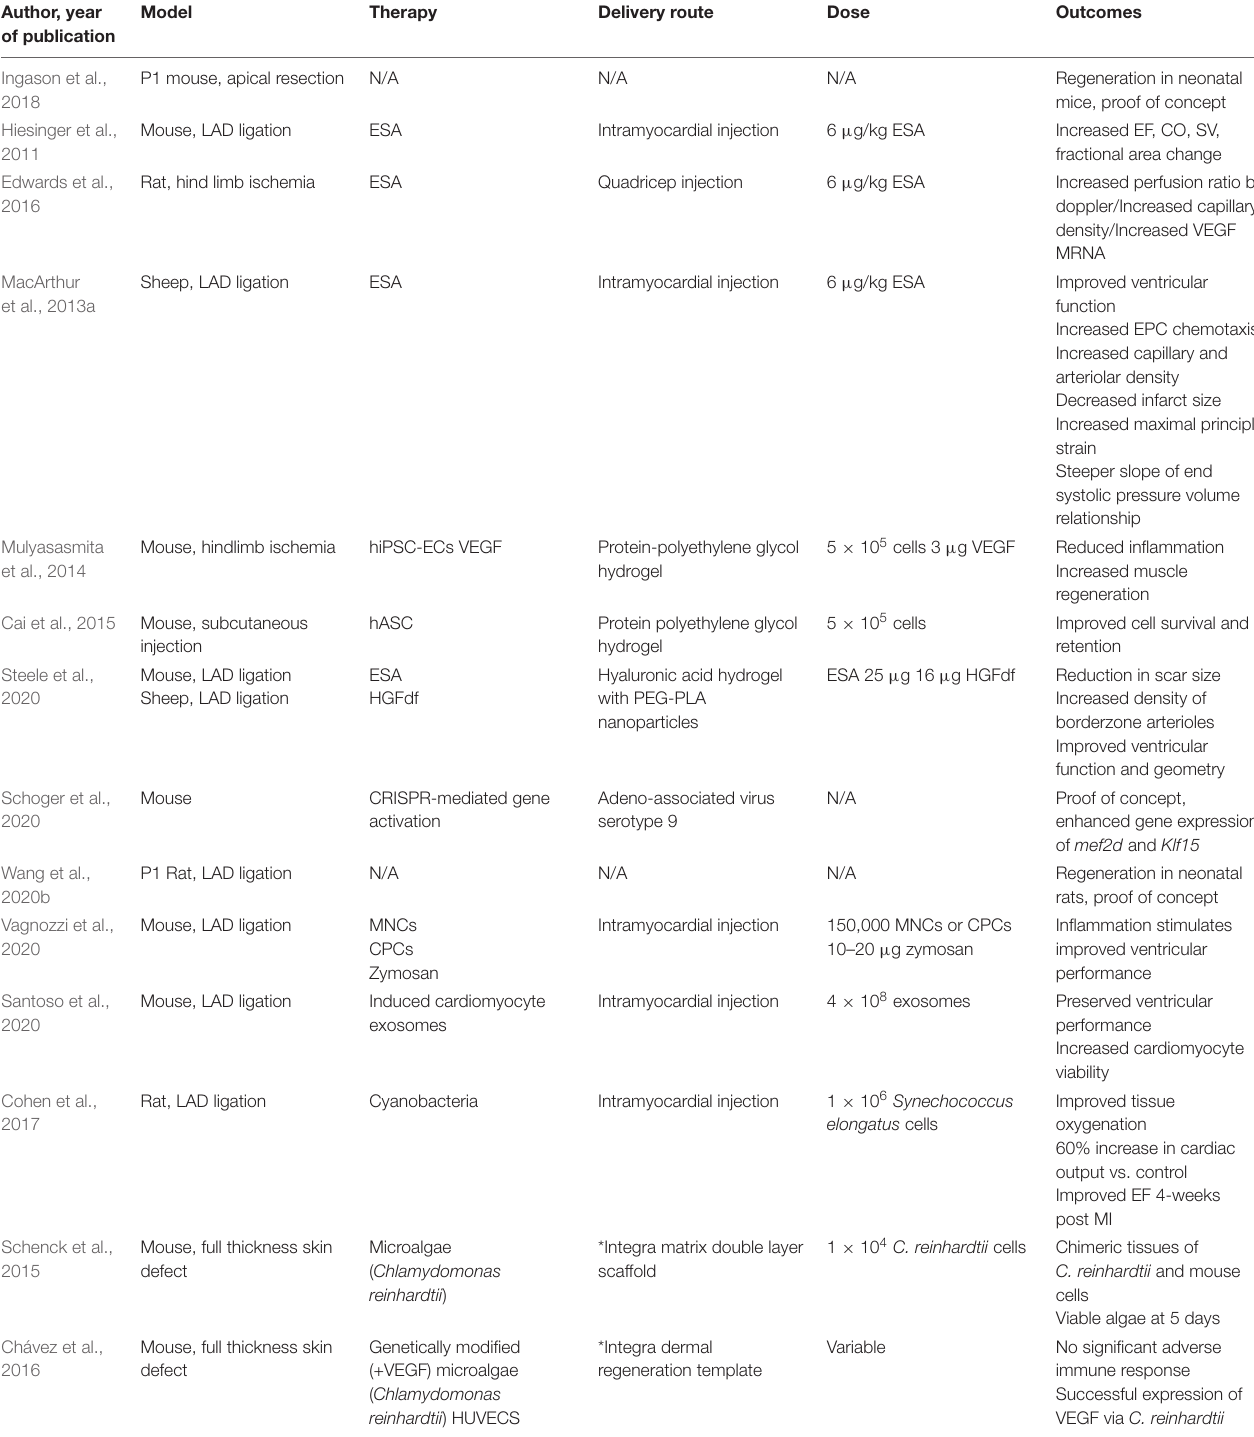
TABLE 1 | In vivo molecular and cellular engineering approaches to myocardial